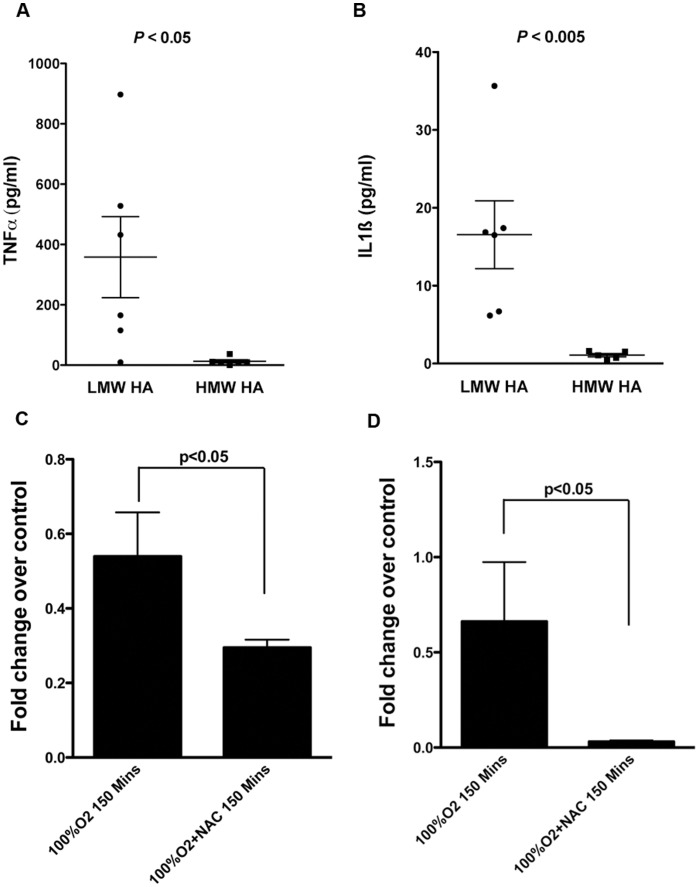
Changes in BAL TNFα and IL1ß concentrations.The BAL contents of TNFα (A) and IL1ß (B) were determined by ELISA were also segregated according to the molecular size of HA. Data are presented as box and whisker plots of 25th and 75th percentiles showing outliers as additional dots. Both inflammatory markers were significantly higher in the animals that had LMW HA in the lung. Newborn pigs resuscitated with 100% O2 and treated with NAC had significantly lower TNFα (C) and IL1ß (D) than those without NAC treatment, suggesting that antioxidant treatment decreases the inflammatory response to resuscitation with hyperoxia.